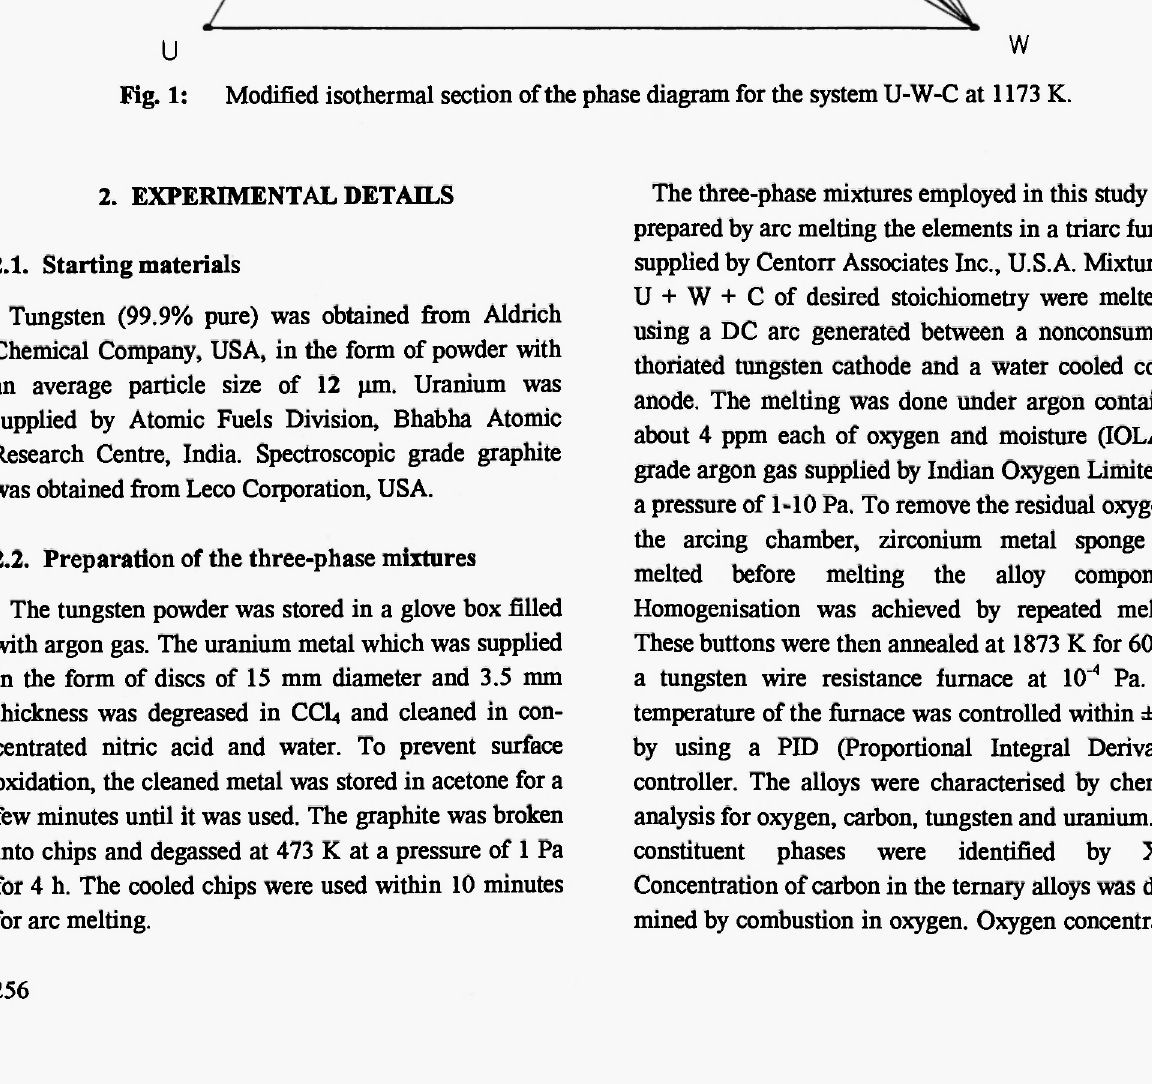
Fig. 1: Modified isothermal section of the phase diagram for the system U-W-C at 1173